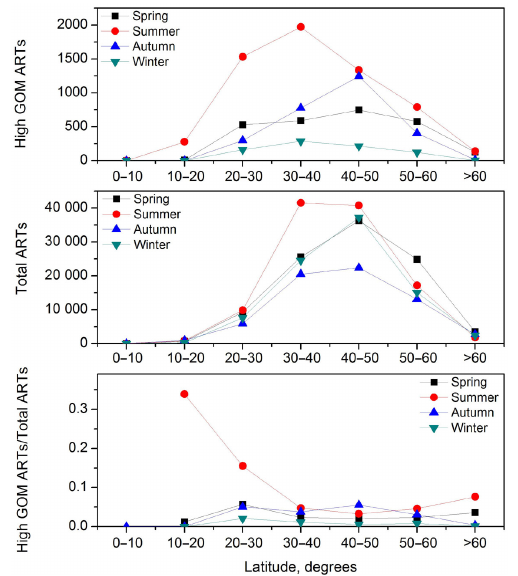
Figure 11. Latitude dependence of Air masses residence times (ARTs, top) associated with high GOM events, total residence times of all the air masses (Total ARTs, middle) and high GOM ARTs / Total ARTs ratios (bottom) over the North Atlantic Ocean for each